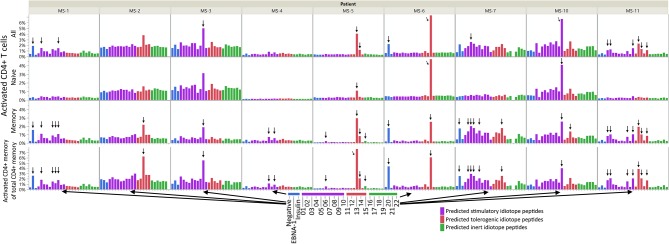
CD4+ T cell responses against idiotope peptides. A total of 500,000 PBMC were left unstimulated, or stimulated with EBNA-1 peptide mix, insulin peptide mix, anti CD3/CD28 beads (not shown), or one of 22 idiotope peptides for 12 h in presence of anti-CD40 antibodies and analyzed by flow cytometry. We gated on CD3+CD4+CD8− T cells and assayed for the activation marker CD154 among all CD4+ cells, CD45RO+ memory-, or CD45RO− naive cells. Activated cells are presented as proportions of all CD4+ cells (upper three panels) or proportion of memory cells (lower panel). Responses were deemed positive (arrows) if the proportion of CD154+ cells were 3x higher than in unstimulated (negative) wells.